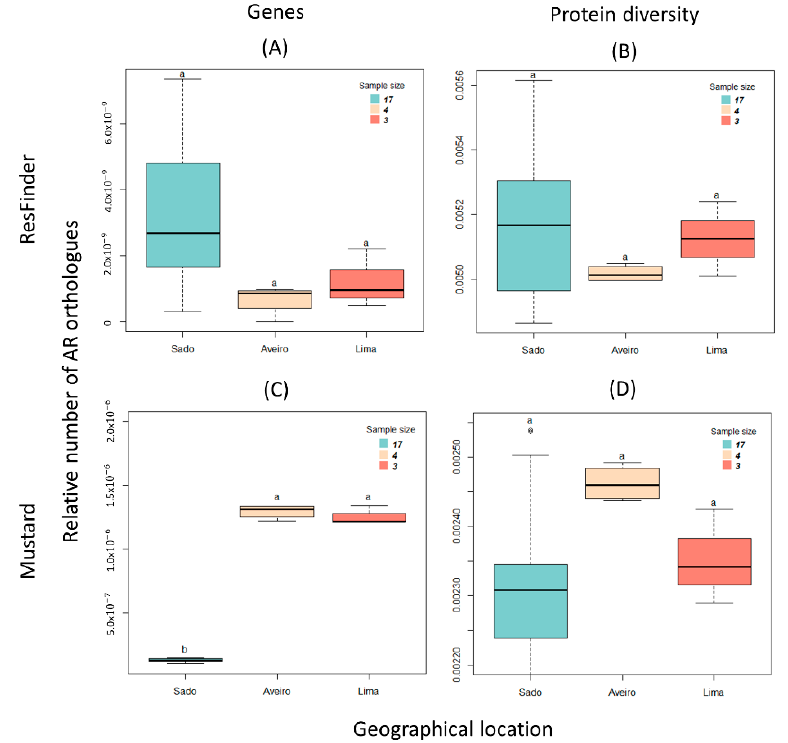
Figure 2. Distribution of antibiotic resistance orthologues by the geographical location of the river or estuary from which they originate: Sado, Aveiro, and Lima. ( A ) A relative number of antibiotic resistance genes using the ResFinder database; ( B ) diversity of AR proteins using the ResFinder database; ( C ) a relative number of antibiotic encoding resistance genes using the Mustard database; and ( D ) diversity of AR proteins using the Mustard database. Each boxplot represents a geographical location, namely the Sado River (blue), Aveiro Lagoon (beige), and Lima River (salmon). The sample sizes are 17, 4, and 3, respectively. The bottom and top of the boxplot represent the first and third quartiles, the horizontal line is the median, and the vertical dashed lines are the 1.5 interquartile range. The black circles represent the outliers. Kruskal–Wallis’s analysis followed by post hoc comparisons using Dunn’s test (see main text) indicated that there are no significant differences between the relative number of determinants of AR between the different geographical locations for ( A ), ( B ) , or ( D ). In ( C ), there is a significant difference between the Sado River and the Aveiro Lagoon, and the Lima River, as indicated by the two different letters a and b ( p -value < 0.05).